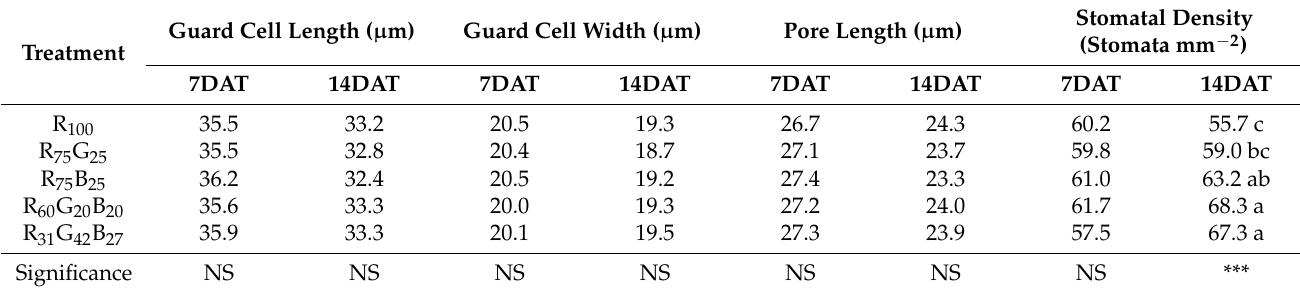
Table 2. Effects of different spectral treatments on the stomatal development of Ocimum basilicum grown under five different combinations of red, green, and blue LEDs with the same light intensity for 14 days after the treatment (DAT). The numbers after each waveband indicate the ratios of the intensities. The R 31 G 42 B 27 treatment mimics the sunlight spectrum measured in the experimental greenhouse. For the measurement of stomatal density, n = 6, and for the other measurements, 30 stomata of each six samples ( n = 180) were analyzed for each treatment. Mean separation followed analysis of variance (ANOVA) with Duncan’s multiple range test at α = 0.05.